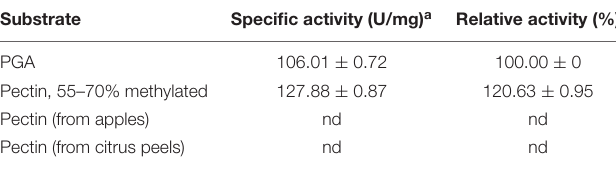
TABLE 3 | Substrate specificity of